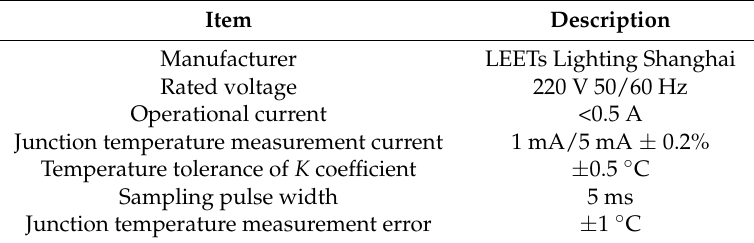
Table 2. Technical characteristics of the LEETS LEDT-300B test